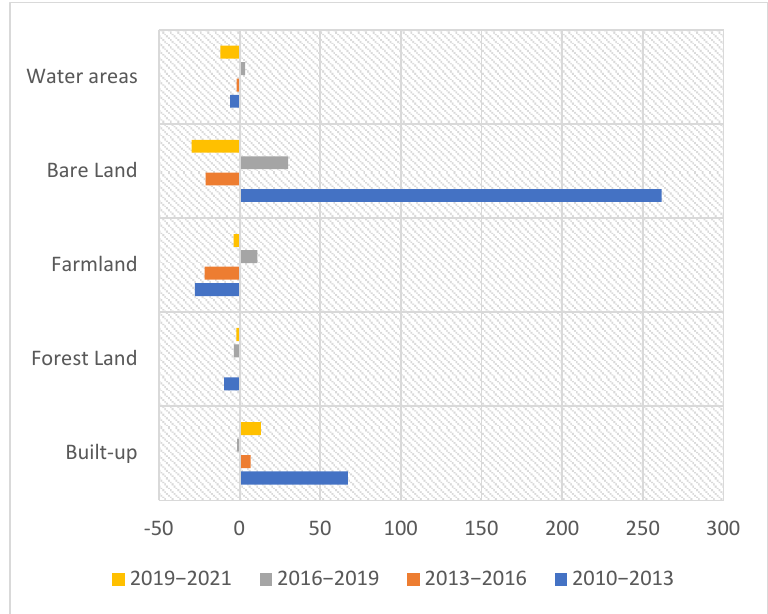
Figure 6. Change intensity (CII).